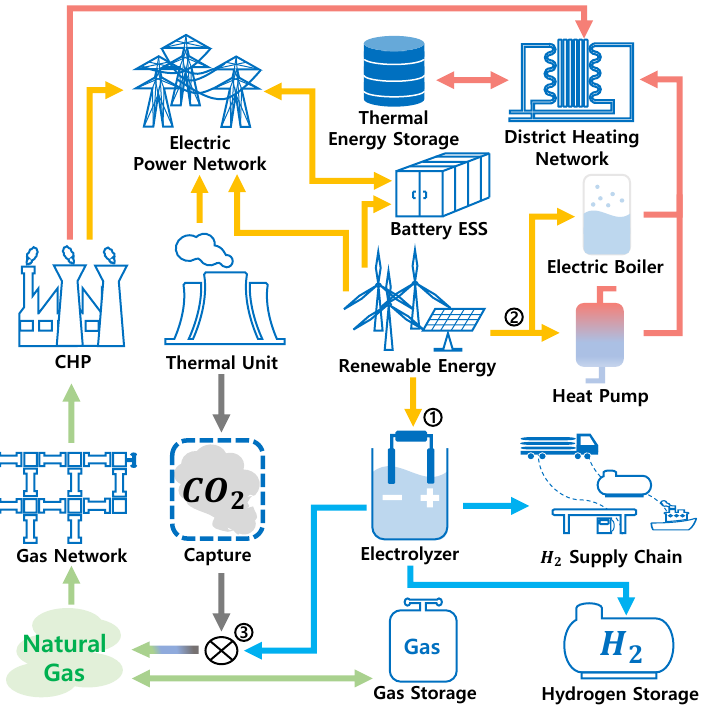
Figure 3. Flow Diagram of Sector